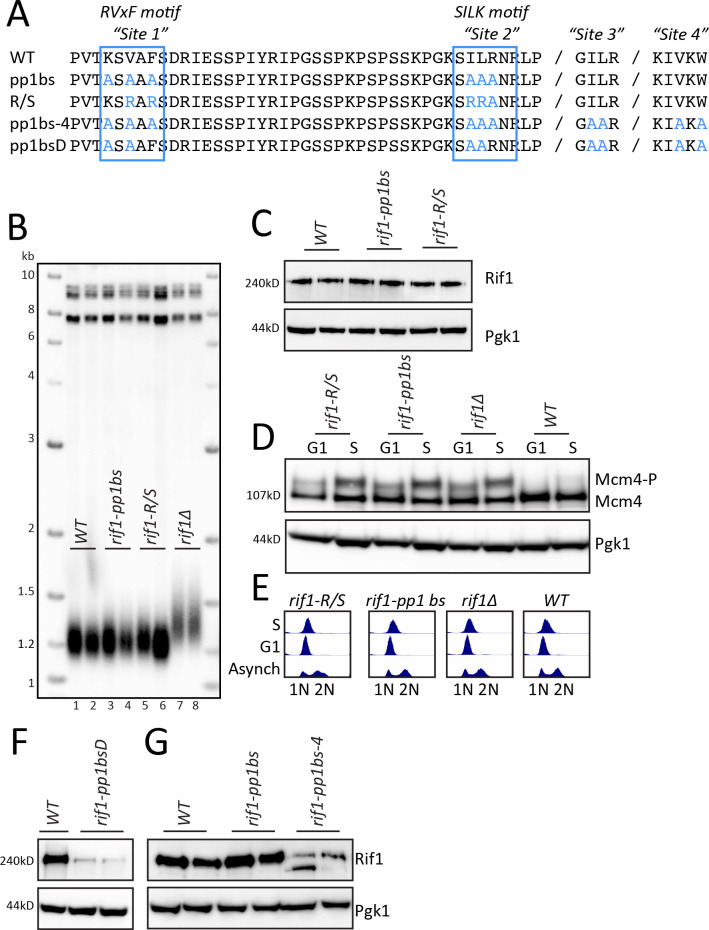
rif1-pp1bs gives similar results to the mutation rif1-R/S (Mattarocci et al., 2014).(A) Sequence comparison of our rif1-pp1bs mutant to the Shore lab rif1-R/S mutant and Donaldson lab rif1-pp1bsD mutant. (B) Southern blot analysis of telomere length of strains indicated. (C) Western blot with WT, rif1-pp1bs and rif1-R/S mutants generated in our lab. (D) Mcm4 phosphorylation levels of rif1-R/S, rif1-pp1bs, rif1∆, or WT. Cells were arrested in G1 with alpha factor (G1) and then released into HU (S); the level of phosphorylation of Mcm4 was detected by western. (E) The DNA content of the arrested cells for D was measured using flow cytometry. (F) Western blot to measure rif1-pp1bsD protein levels in ASy26 (WT), SMKy30 (rif1-pp1bsD), and SMKy31 (rif1-pp1bsD) strains sent from Donaldson lab. (G) Rif1 protein levels were measured by western blot for Rif1 and rif1-pp1bs compared to a rif1-pp1bs-4 site that we generated.